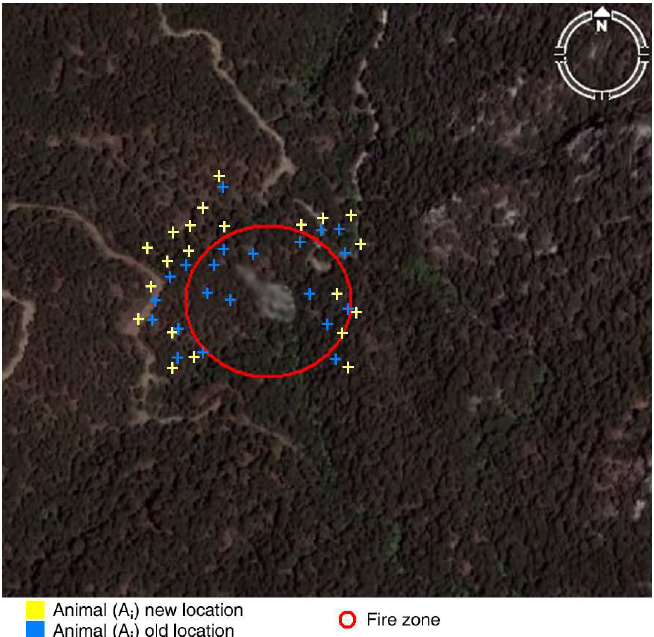
Figure 9. Monitoring animals locations via